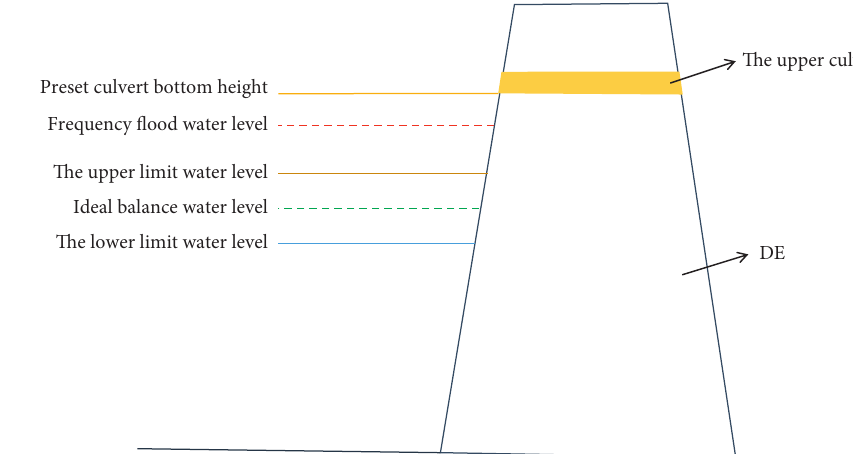
Figure 14: Engineering significance of upper limit water level. Table 4: Criterion for the setting of the upper